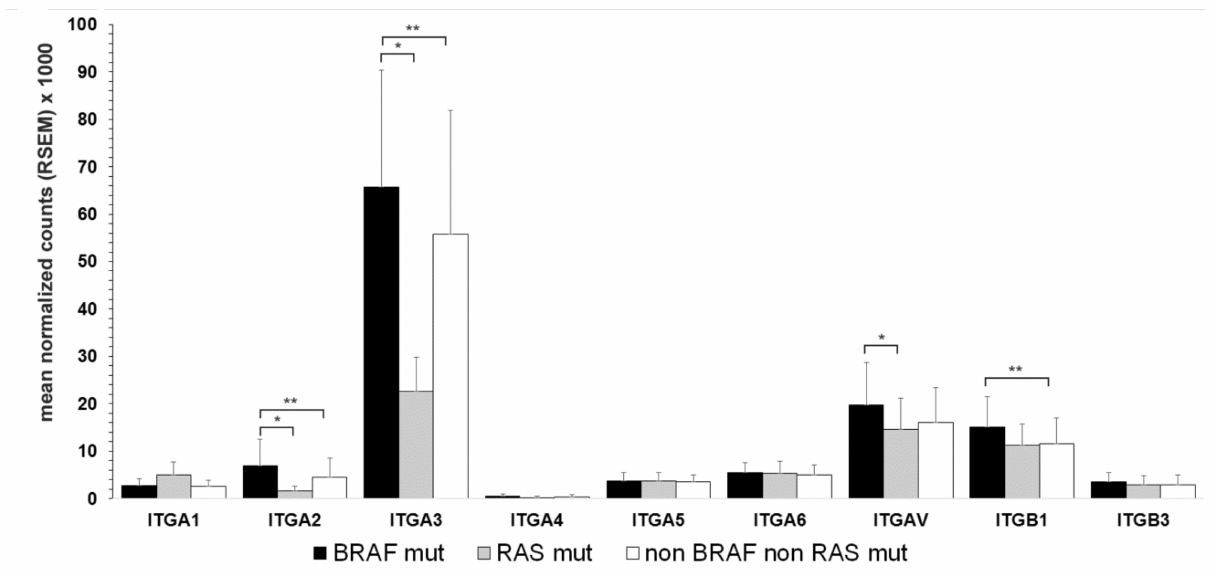
Figure 3. Correlation between integrin expression and driver mutations in PTCcl. Integrin subunits expression were determined in PTCcl with BRAF mutation (BRAF mut), RAS mutation (RAS mut) or none of both (non BRAF non-RAS). Mean and standard deviation; ANOVA p < 0.01 for all subunits except for ITGA 4, 5, and 6. Wilcoxon: * p < 0.0001, ** p < 0.001.